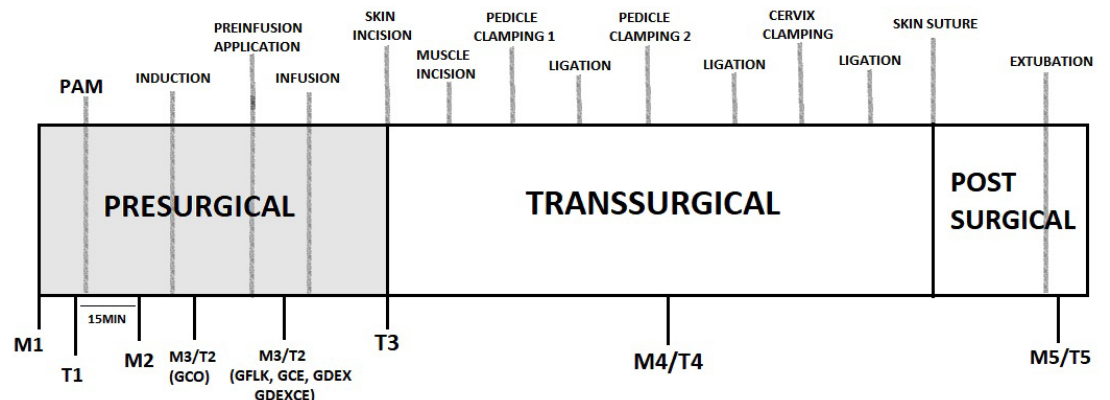
Figure 1. Schematic representation of the experimental moments for data collection during the study (Santos et al., 2015 -